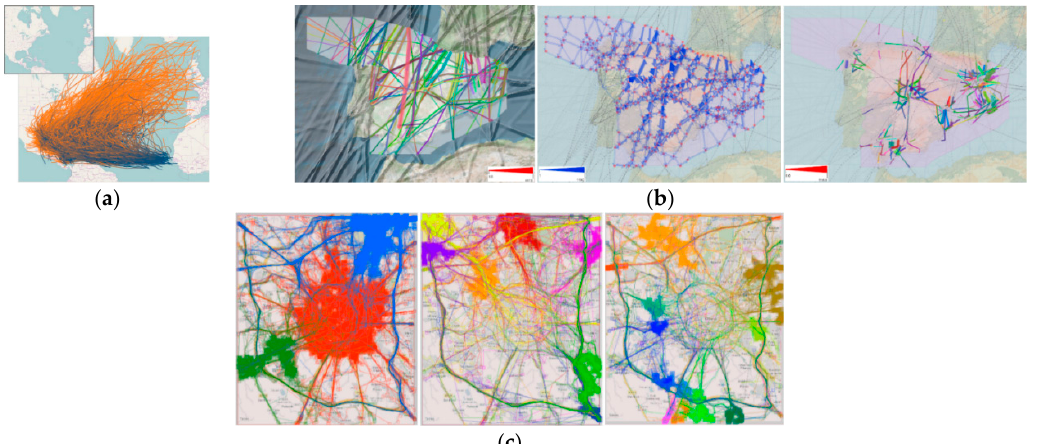
Figure 42. Visualization examples of spatial cluster separation: ( a ) reconstruction of a generalized air traffic network by selecting and clustering relevant parts of flight trajectories [105]; ( b ) visualization results of vector field k-means clustering hurricane trajectories [108]; and ( c ) top-down hierarchical compartmentalization of the original dataset by progressive clustering, where the largest clusters are hierarchically and gradually removed to reveal secondary clustering results [109].